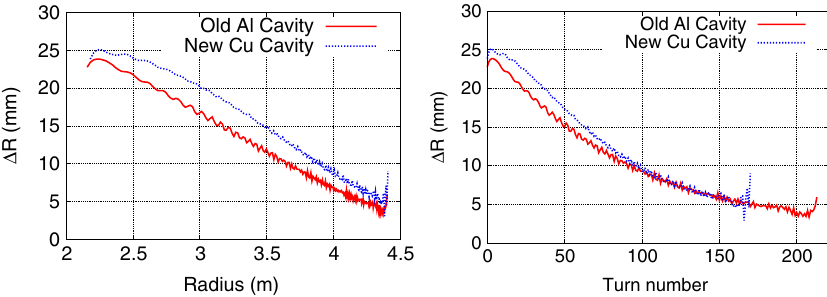
FIG. 1. (Color) Comparison of calculated turn separation for centroid particles before (red line) and after (blue line) upgrade of the PSI ring cyclotron. The main cavity voltage is set to 0.735 and 0.9 MV for aluminum and copper, respectively, while the flattop is set to 11.2% of the main